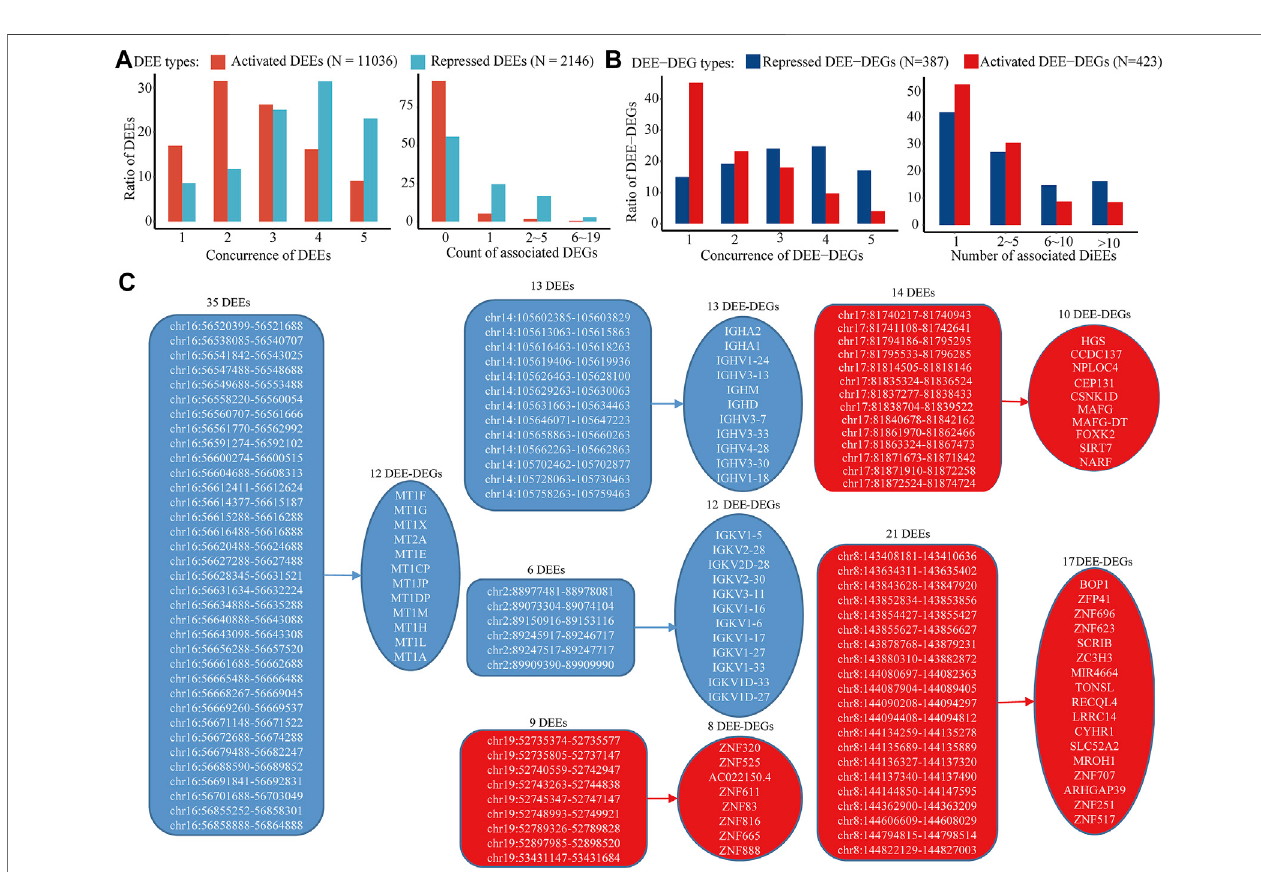
FIGURE3 | Distinct patternsof activated and repressed intergenic enhancers in HCC. (A) (left) Distribution ofthe concurrenceof identi fi ed intergenicDEEsamong fi ve RNA-seq datasets and (right) distribution of the number of associated intergenic DEE-DEG of each DEE. (B) (left) Distribution of the concurrence of identi fi ed intergenic DEE-DEGs among fi ve RNA-seq datasets and (right) distribution of the number of associated DEE of each DEE-DEG. (C) Gene clusters associated with aberrant super-enhancers. Only gene clusters with at least fi ve DEE-DEGs and super-enhancers with at least fi ve DEEs were displayed. Activated DEEs and DEE- DEGs are shown in red color, and repressed DEEs and DEE-DEGs are shown in blue.